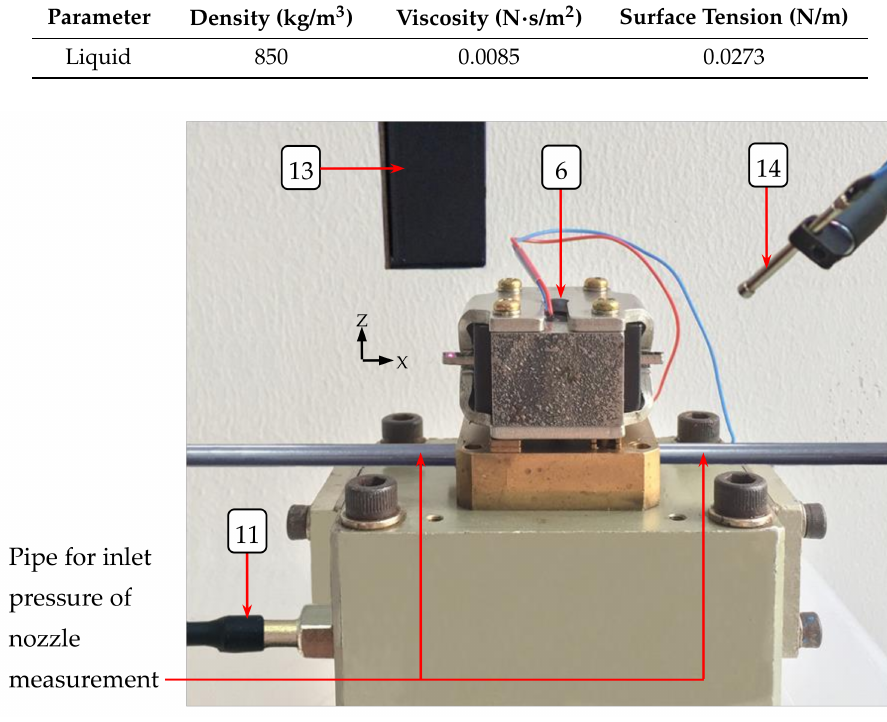
Figure 7. Picture of the experimental